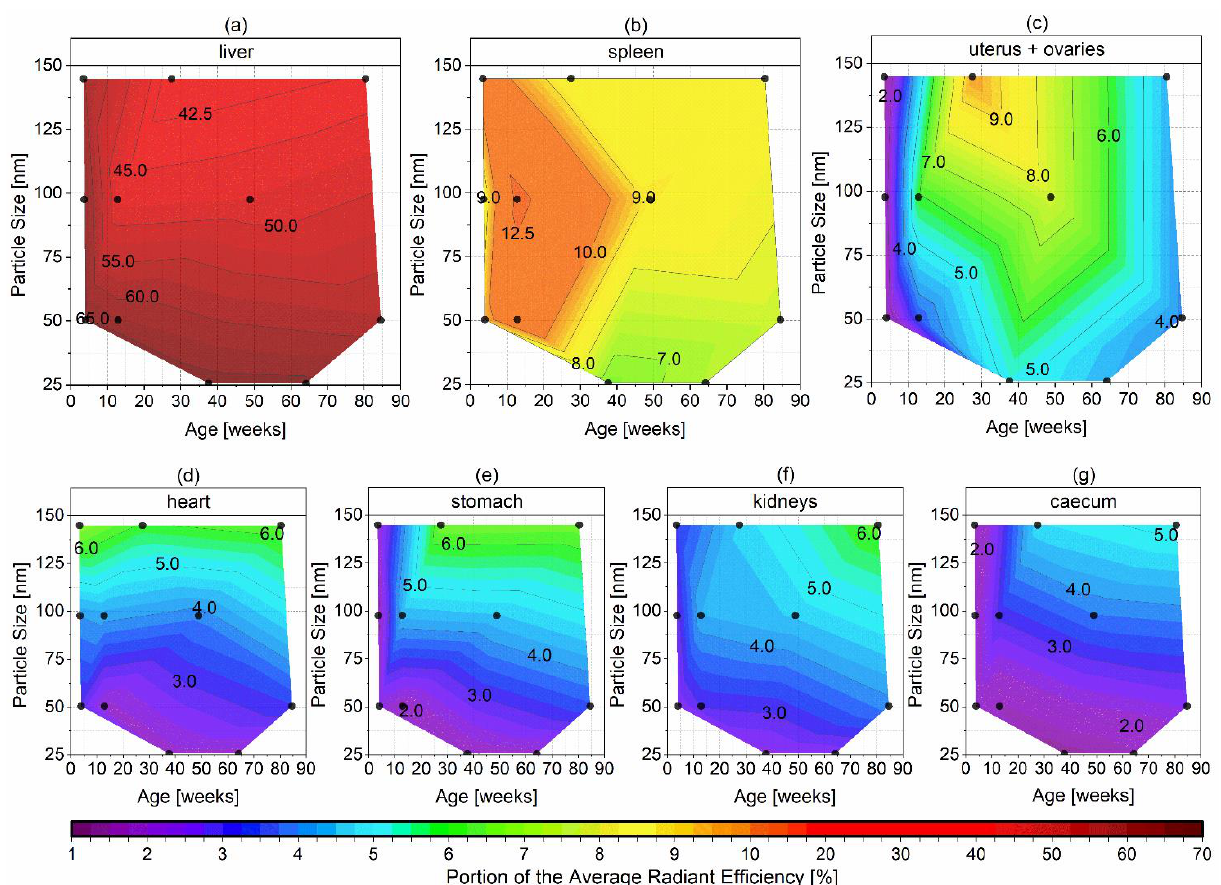
Figure 7. Logarithmic contour plots of the mean PARE for the organs with the highest accumulations (( a ) liver, ( b ) spleen, ( c ) uterus + ovaries, ( d ) heart, ( e ) stomach, ( f ) kidneys, and ( g ) caecum) plotted against the particle size of the i.v. injected nanoemulsions and the exact age of the mice displayed as ●.